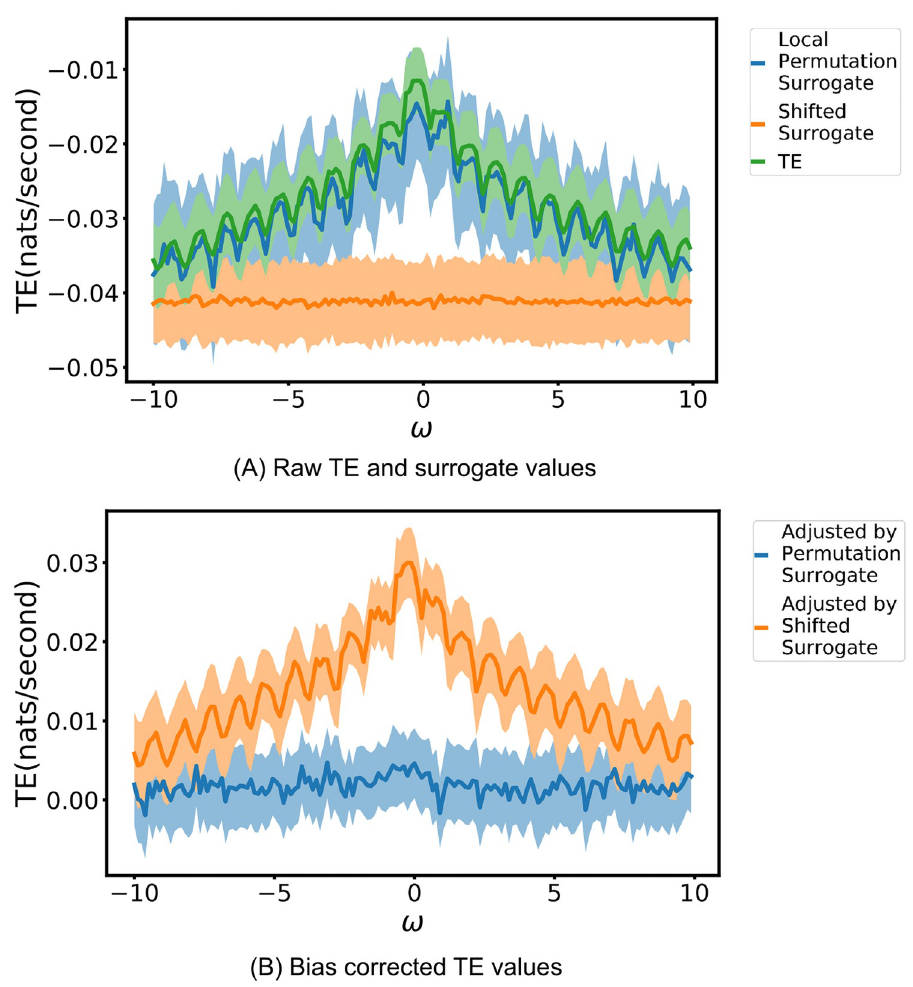
Fig 6. Results of the continuous-time estimator run on a noisy copy process _ T , where conditioning on a D 1 ! D 2 j M strong common driver M should lead to zero information flow being inferred. The translation ω of the source, relative to the target and common driver, controls the strength of the correlation between the source and target (maximal at zero translation). For each translation, the estimator is run on both the original process as well as embeddings generated via two surrogate generation methods: our proposed local permutation method and a traditional source time-shift method. The solid lines show the average TE rate across multiple runs and the shaded areas span from one standard deviation below the mean to one standard deviation above it. The bias of the estimator changes with the translation ω , and we expect the estimates to be consistent with appropriately generated surrogates reflecting the same strong common driver effect. This is the case for our local permutation surrogates, as shown in (A). This leads to the correct bias-corrected TE value of 0, as shown in